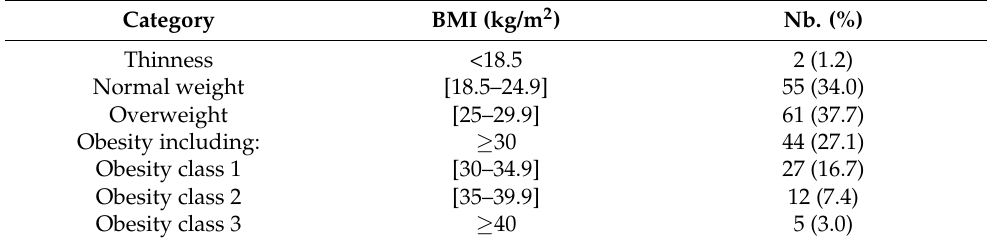
Table 4. Distribution of BMI in the population ( n = 162).